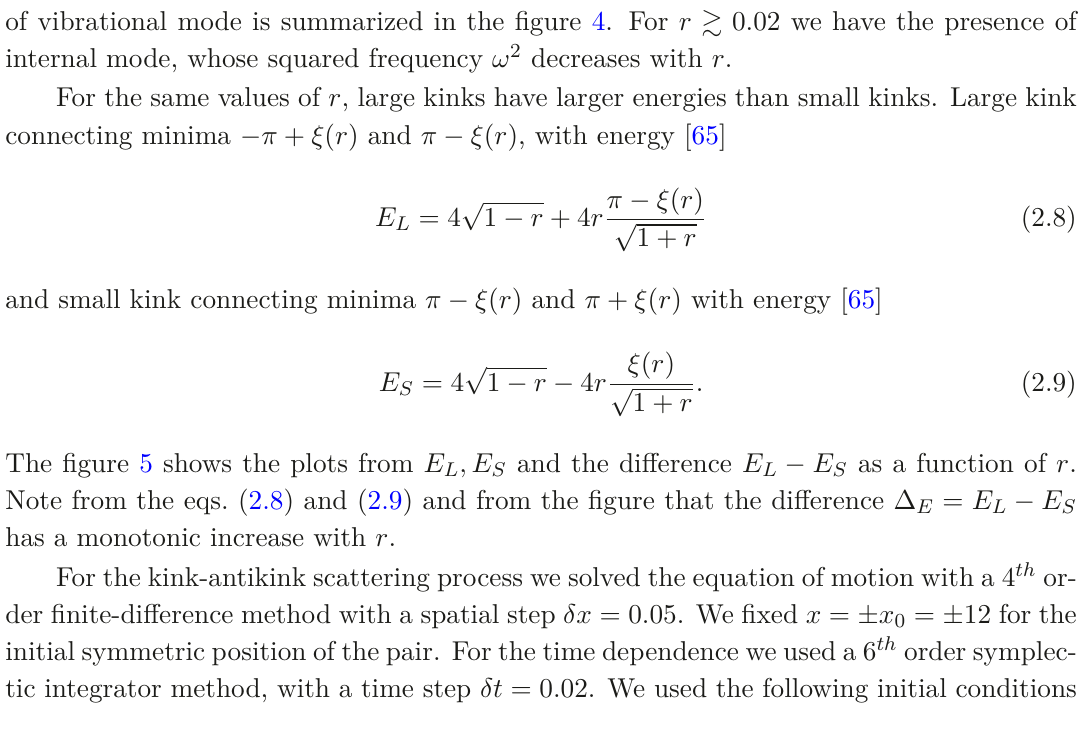
Figure 5 . Energy E L of large kink (red), E S of small kink (blue) and the difference ∆ E = E L (green) as a function of r